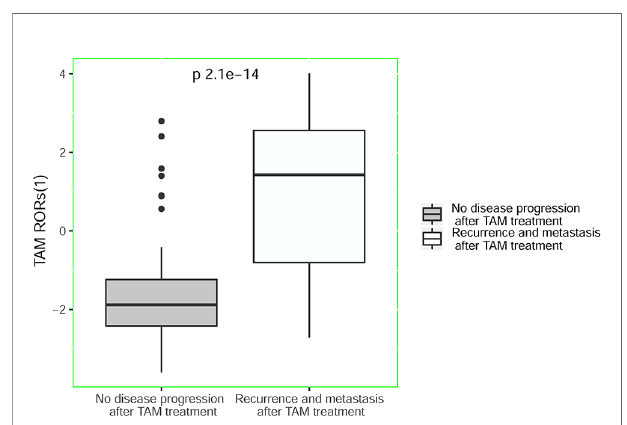
FIGURE 2 | TAM RORs predicts recurrence and metastasis in breast cancer. Box-whisker plots of TAM RORs (1) values. TAM RORs, tamoxifen risk-of-